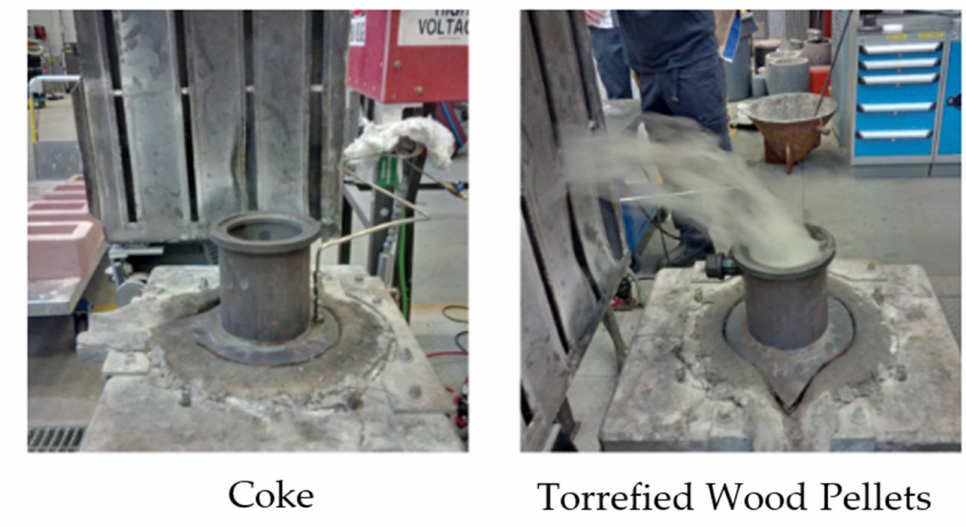
Figure 4. Observations of smoke production.